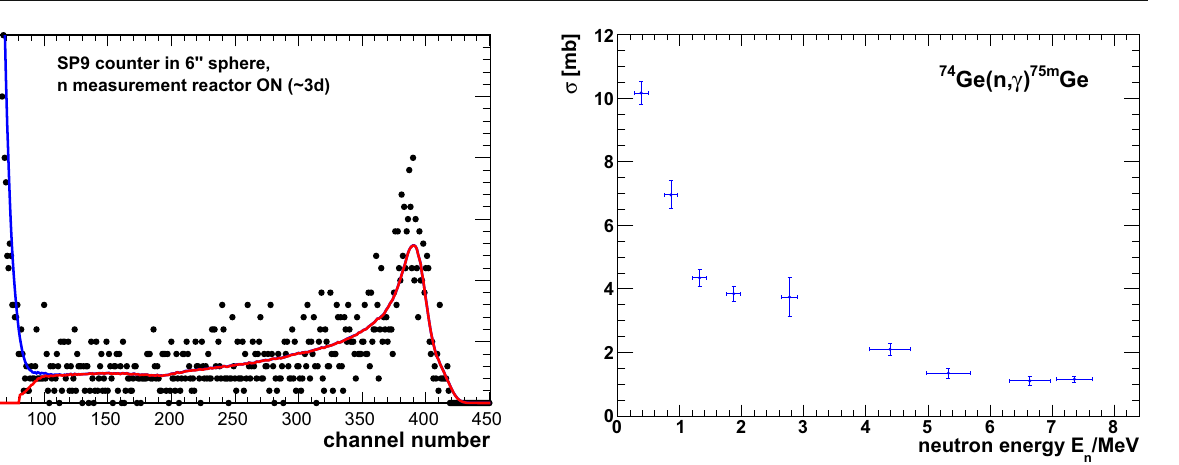
Fig. 3 Cross section for neutron capture on 74 Ge to the 139.7keV state of 75m Ge, data from [16]. The cross section for thermal neutrons with ( 130 . 5 ± 5 . 6 ) mb [17] exceeds the values at higher energy shown in the plot by one order of